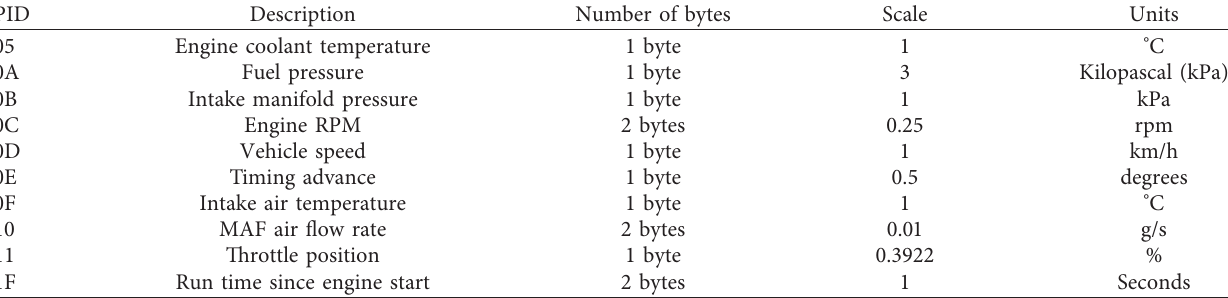
Table 2: Some PID codes and their meaning.